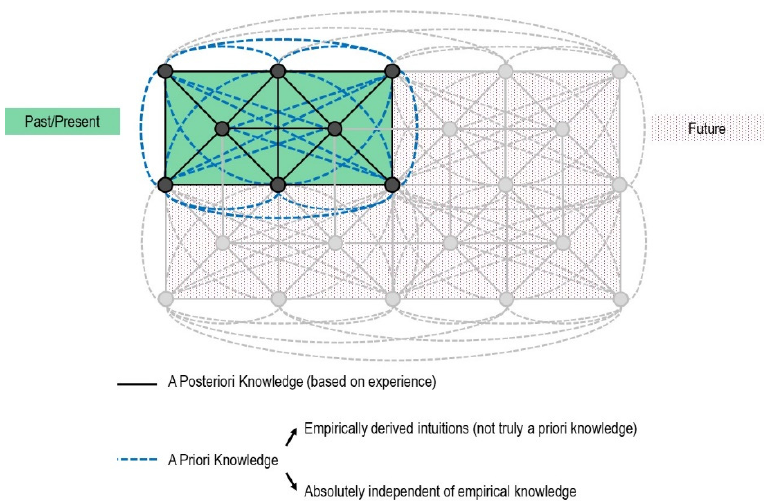
Figure 3. Conceptual scheme of engineering knowledge in the form of a network of learning nodes.